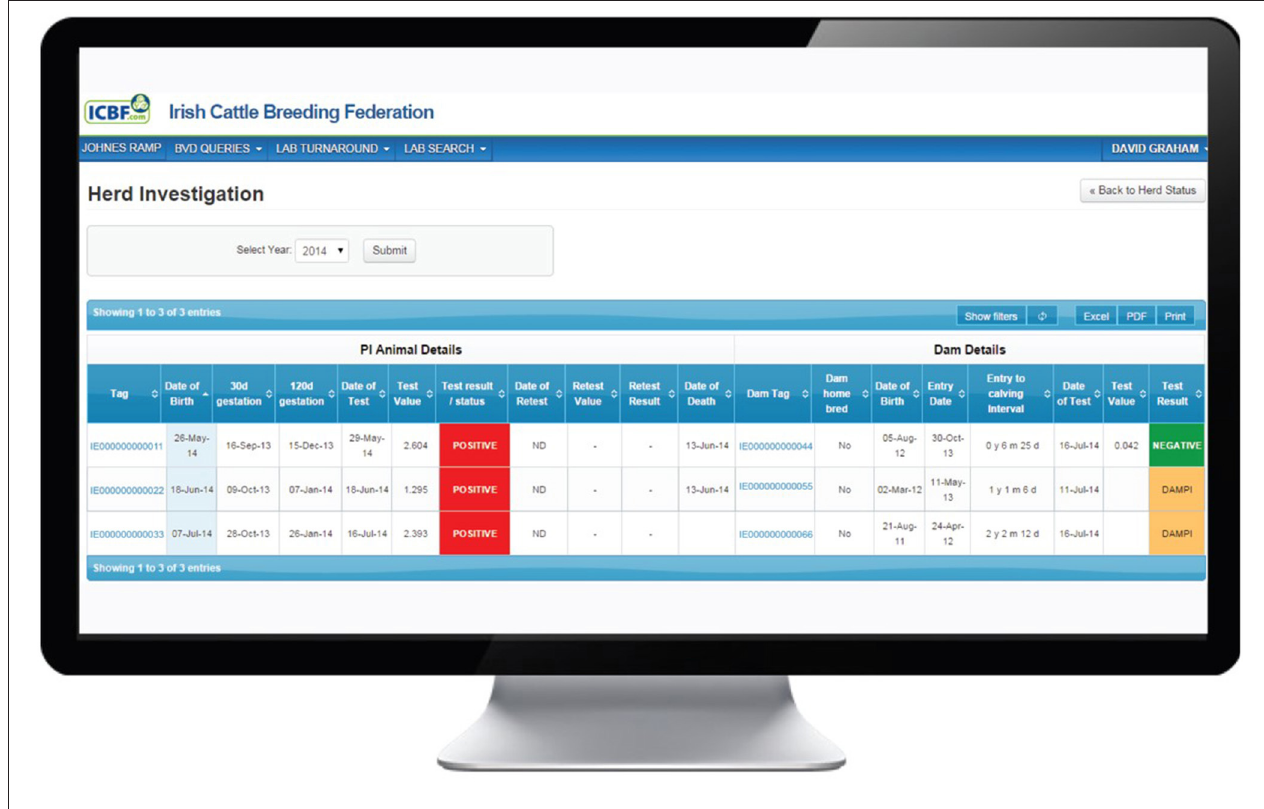
FIGURE 2 | Investigation screen on the BVD herd-level dashboard provided by ICBF, providing details of each animal with a positive or inconclusive result in the herd, including date of commencement and conclusion of the window of susceptibility, and associated dam details.